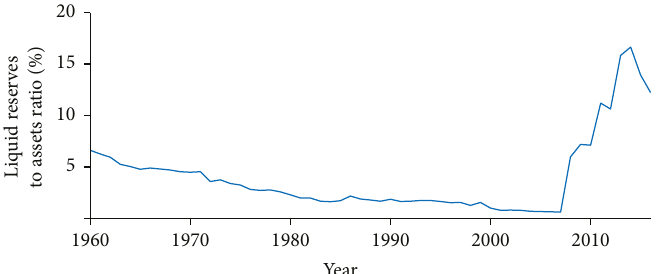
Figure 1: Ratio of bank liquid reserves to bank assets in the United States (1960 – 2016), that is, the ratio of domestic currency holdings and deposits with the monetary authorities to claims on other governments, non fi nancial public enterprises, the private sector, and other banking institutions. The recent 2007 – 2008 fi nancial crisis led banks to hoard liquidity. Source: the World Bank, retrieved from http://WorldBank. com and http://NationMaster.com.